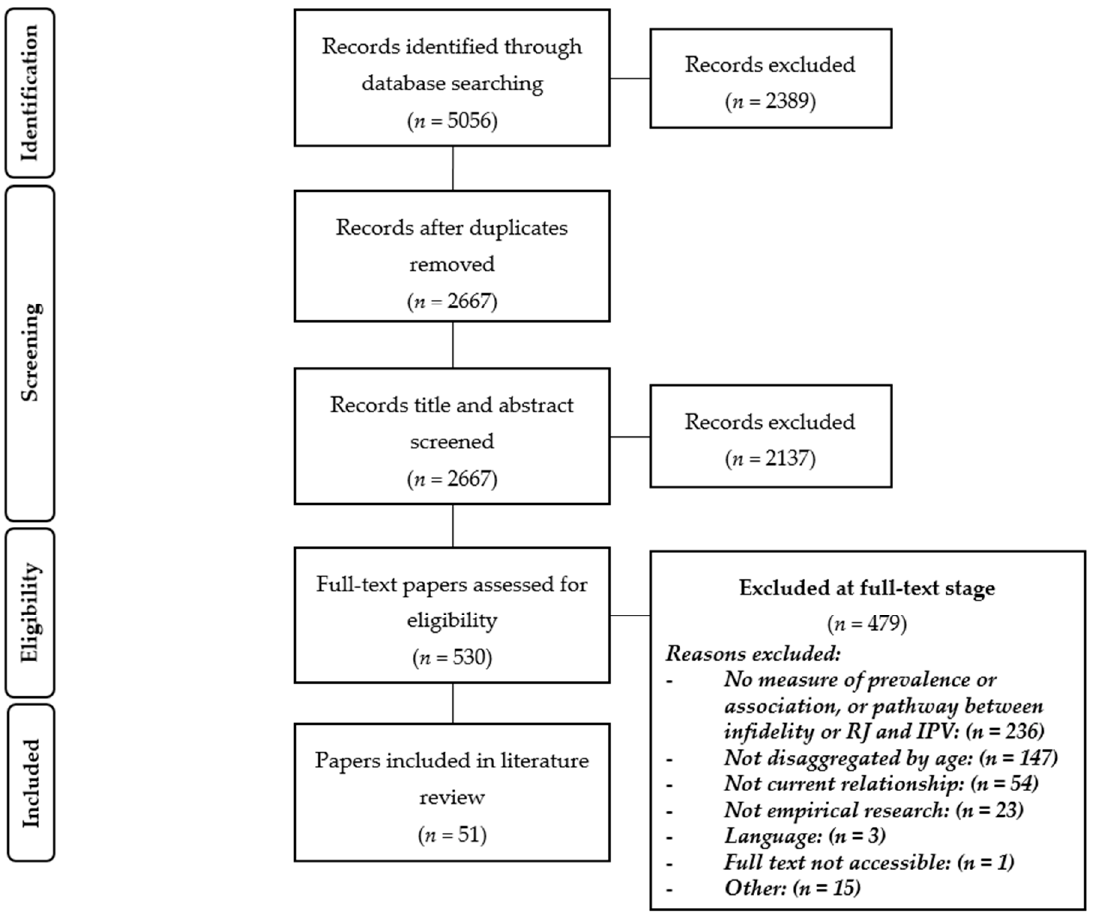
Figure 1. PRISMA 2009 flowchart of the study selection process.